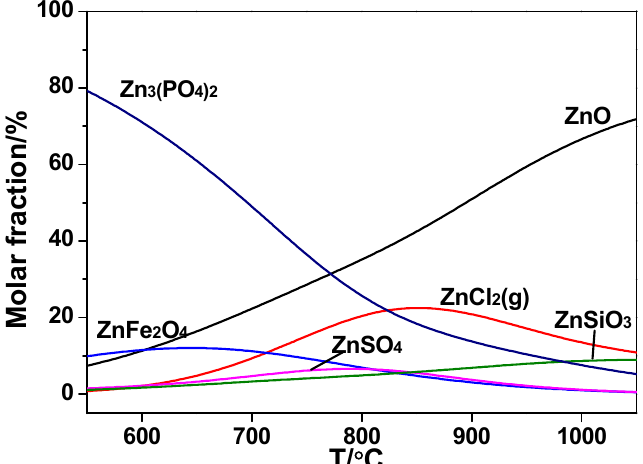
Figure 9. Effect of temperature on the distribution of Zn species in the combustion of sludge in thermodynamics.